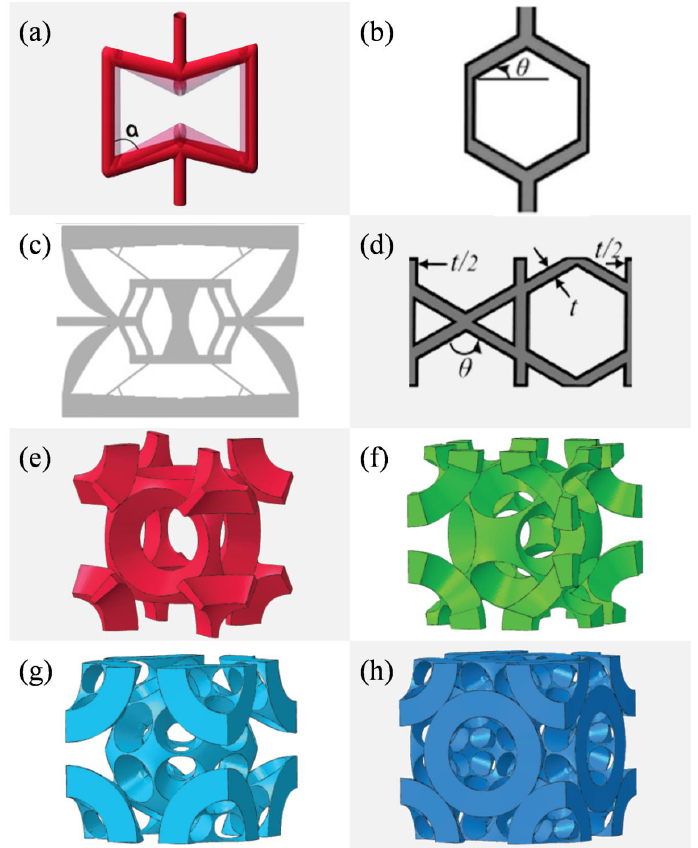
Figure 3. Overview of di ff erent unit cells which will be challenging to manufacture but propose very interesting properties for mechanical metamaterials: ( a ) basic bow tie [16], ( b ): honeycomb [3], ( c ): auxetic bow tie [2], ( d ): kagome based unit cell [3], ( e – h ): bucklicrystals with di ff ering amounts of holes arranged body centered cubic (BCC) or face centered cubic (FCC) [57]: ( e ) 6-hole BCC, ( f ): 12-hole BCC, ( g ): 24-hole BCC, ( h ): 24-hole FCC. Figures are reproduced and adapted with permission